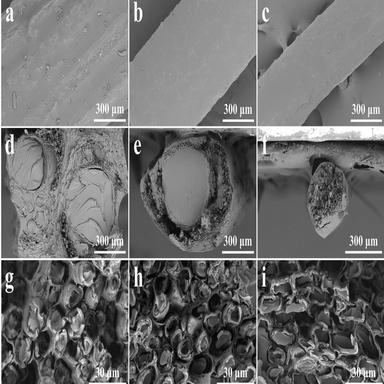
Longitudinal SEM images of (a) TFL, (b) TFM, and (c) TFS. Fracture surface SEM images of (d) TFL, (e) TFM, and (f) TFS. Fracture surface SEM images of tracheids of (g) TFL, (h) TFM, and (i) TFS.